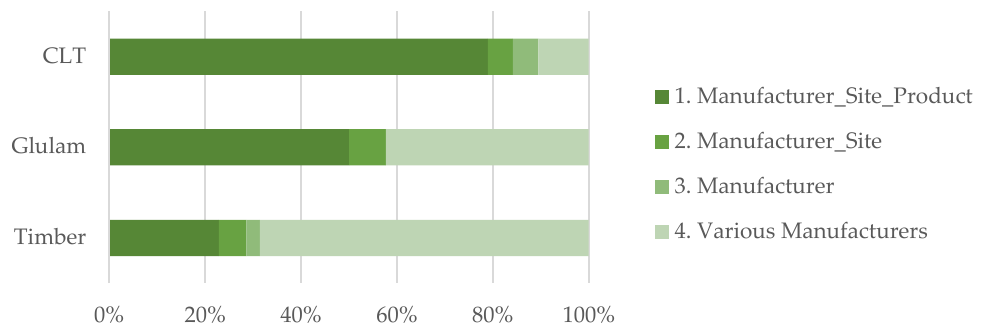
Figure 9. Specificity of EPDs in the areas of manufacturer, facility, and co-production, presented as category 1 – 4.